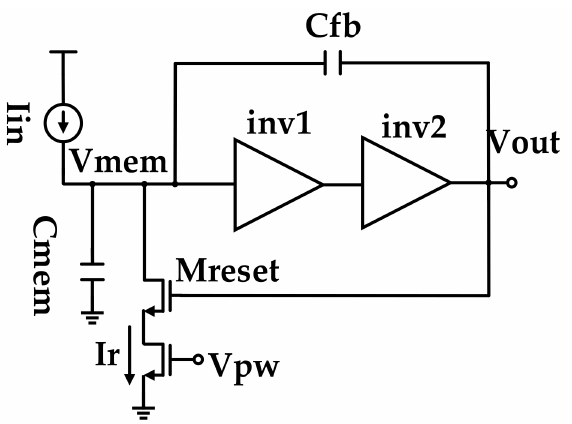
Figure 3. Traditional Axon-Hillock structure. I in is the current generated by the photodiode. C mem is the capacitor of the neural